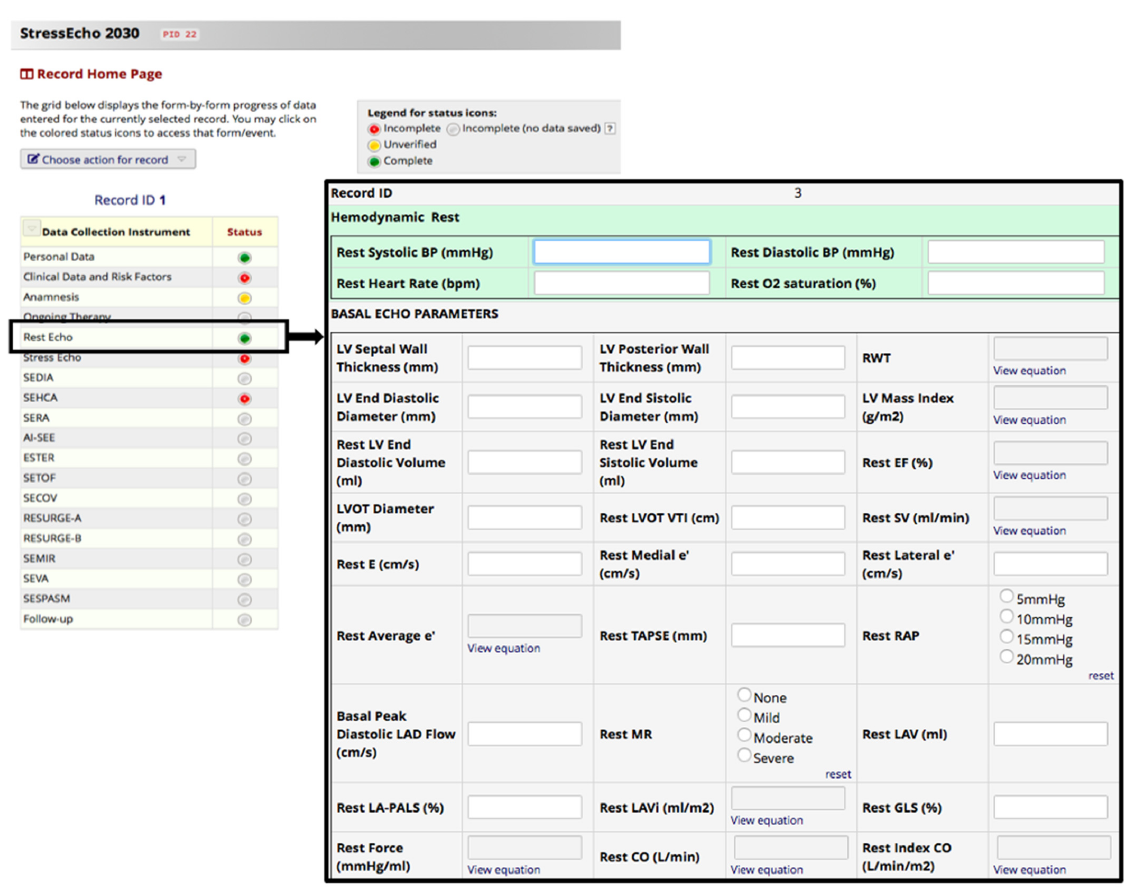
Figure 2. Record status dashboard. eCRF pages and REDCap functional modules are accessible to end-users by clicking links on each project’s right-side application menu.